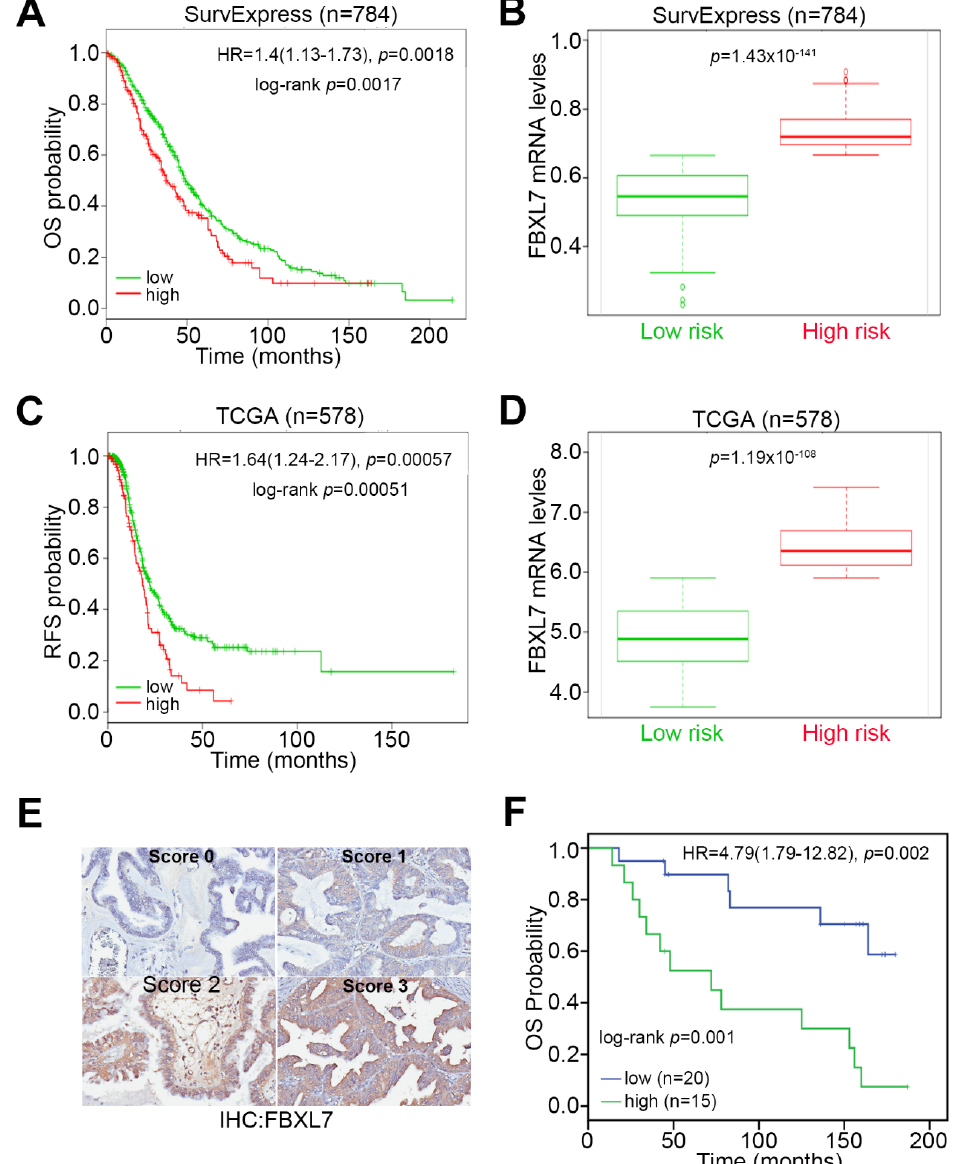
Figure 4. FBXL7 upregulation refers to an unfavorable outcome in ovarian cancer patients. ( A ) K-M analysis for FBXL7 expression under the condition of overall survival (OS) probability in ovarian cancer patients using the SurvExpress database. ( B ) Boxplot for the mRNA levels of FBXL7 in low (green) and high (red)-risk cohorts in ( A ). ( C ) K-M analysis for FBXL7 expression under the condition of recurrence-free survival (RFS) probability in ovarian cancer patients using the TCGA database. ( D ) Boxplot for the mRNA levels of FBXL7 in low (green) and high (red)-risk cohorts in ( C ). ( E and F ) Immunohistochemistry (IHC) staining for FBXL7 protein ( E ) in ovarian cancer tissues and Kaplan-Meier analysis ( F ) under the condition of OS probability basing on the IHC staining intensities (low, Scores 0 and 1; high, Scores 2 and 3) of FBXL7 against the ovarian cancer patients with papillary serous cystadenocarcinoma. In A , C , F , HR denotes hazard